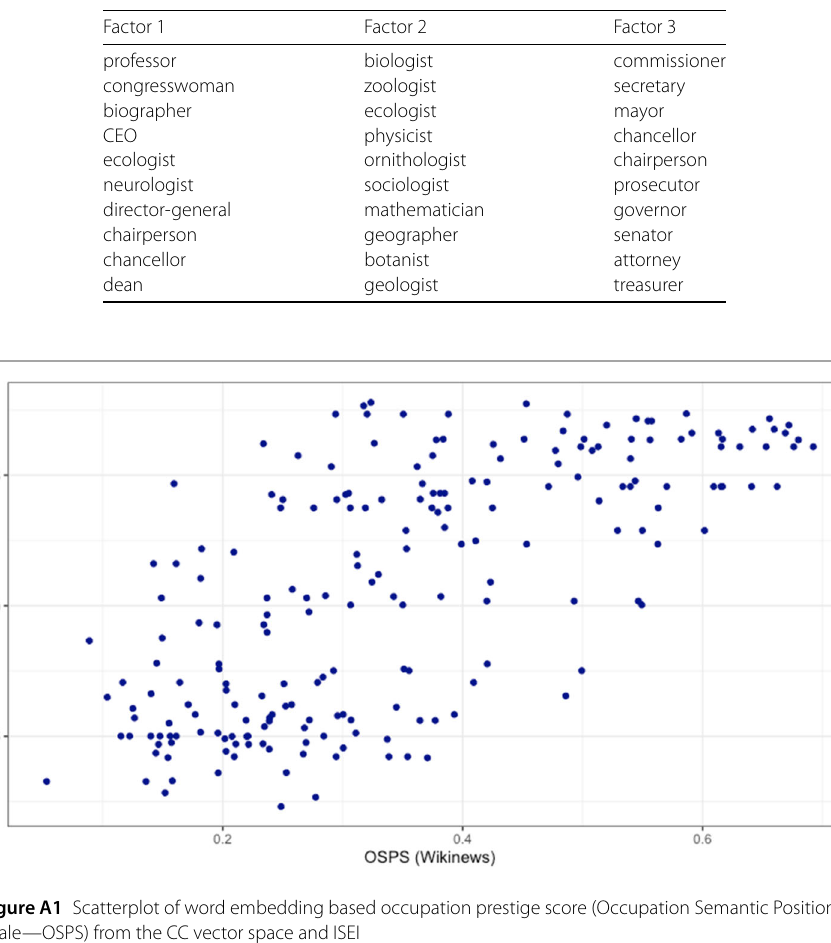
Figure A1 Scatterplot of word embedding based occupation prestige score (Occupation Semantic Position Scale—OSPS) from the CC vector space and